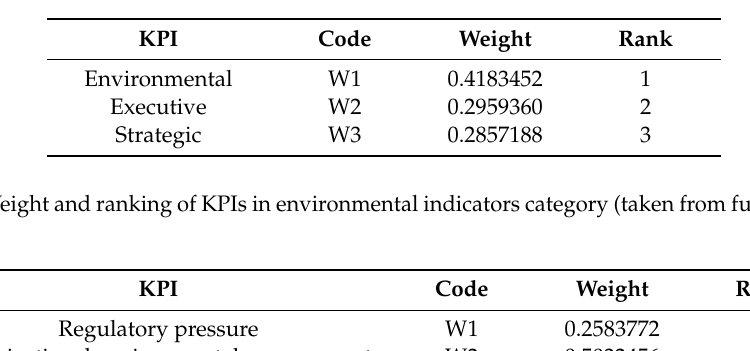
Table 13. Weight and ranking of KPIs in main category (taken from fuzzy nonlinear model).